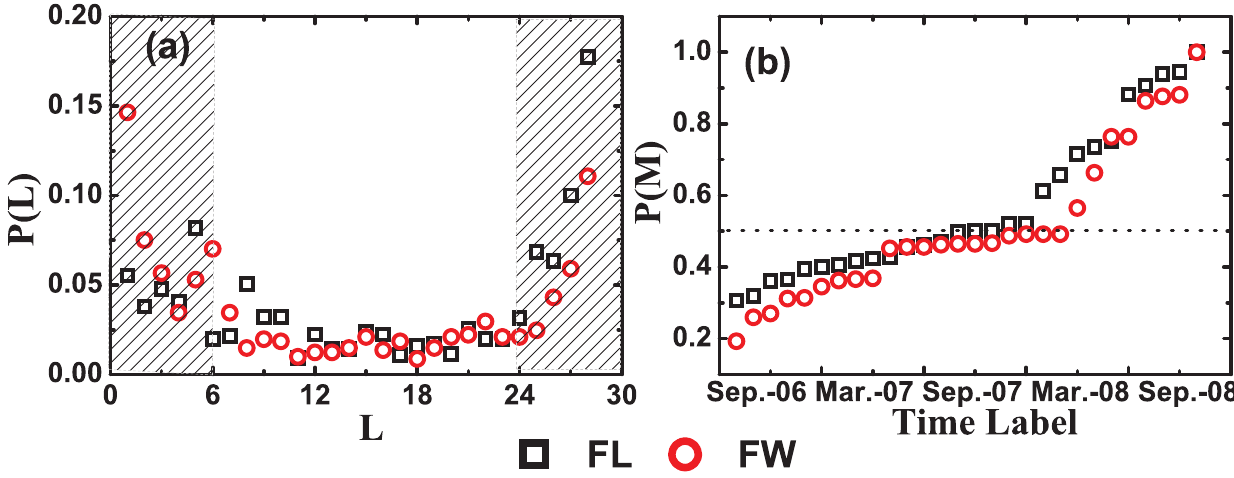
Figure 5. (Color online) The life span of nodes staying in the cores. (a) The distribution P(L) has ‘U’ shaped feature. There are lots of nodes whose existing times are less than 6 or more than 24, and less users whose existing times are larger than 6 and smaller than 24. (b) The distribution P(M) of the nodes who exists in the cores from the t th snapshot to the last one. There are more than 50% nodes belong to the cores for more than one year, 19% nodes always belong to the cores from the first snapshot.